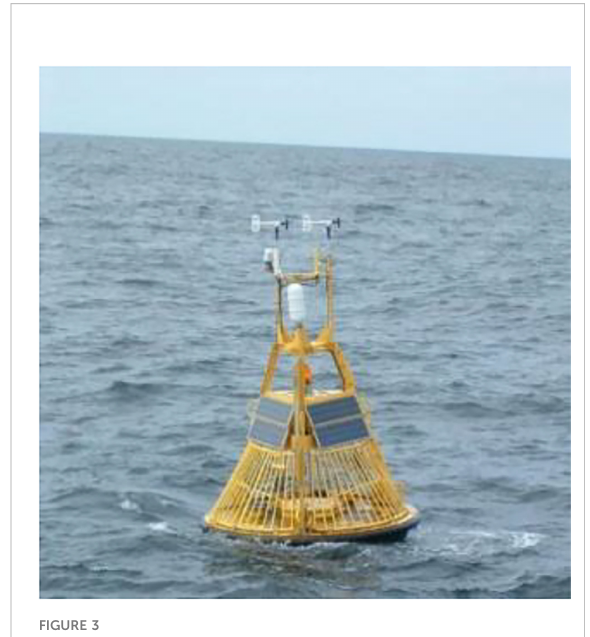
FIGURE 3 Buoy Cape Elizabeth (https://www.pmel.noaa.gov/co2/story/ Cape+Elizabeth).